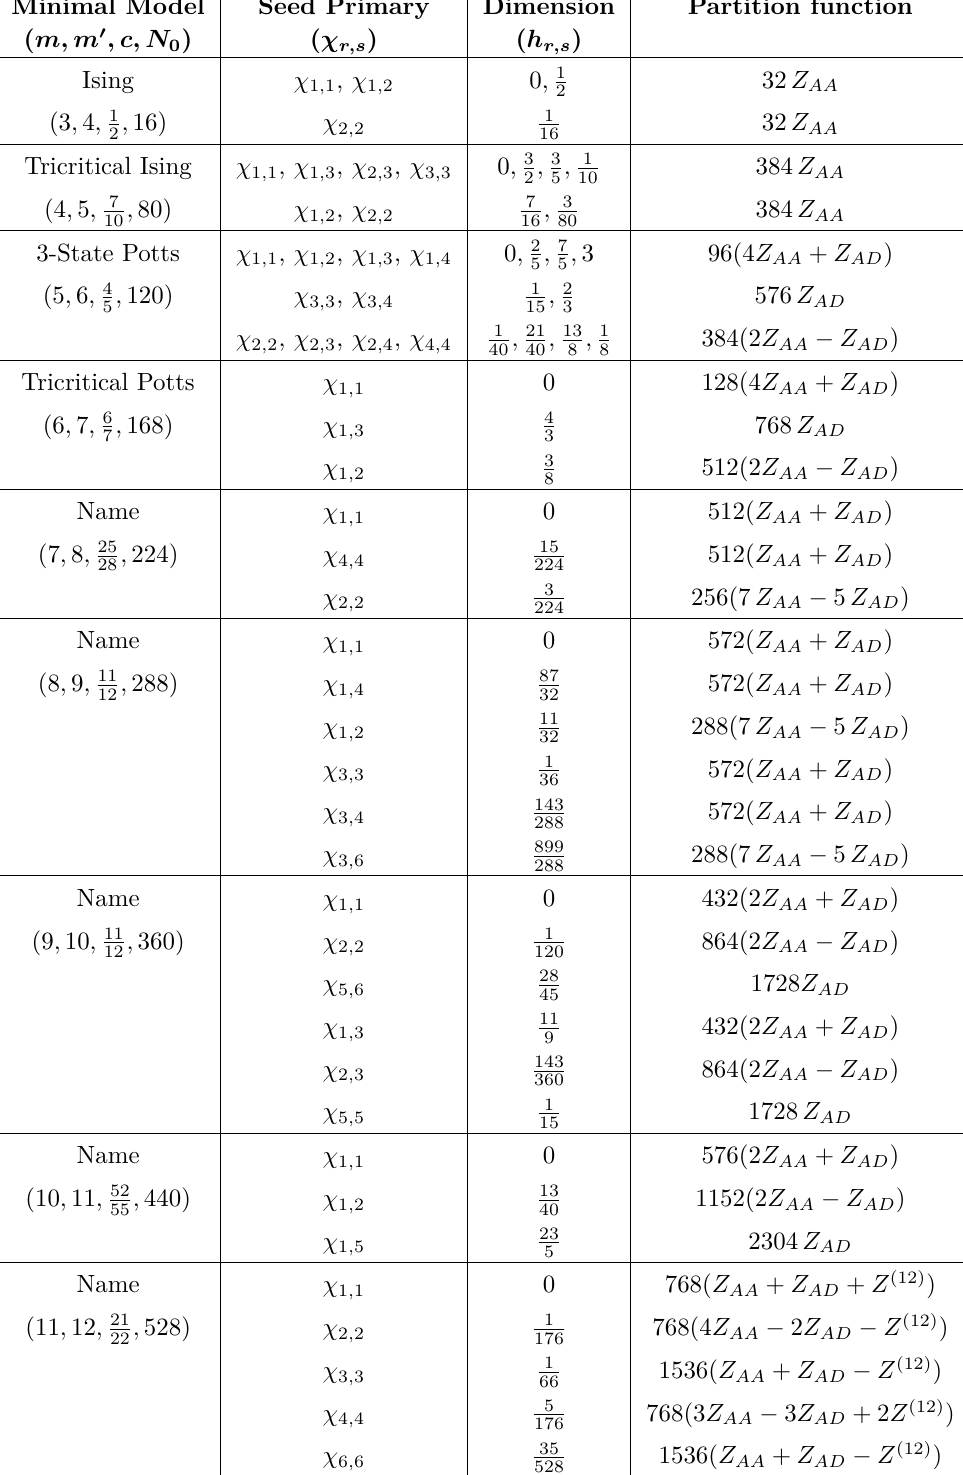
Table 8. Poincaré Sums for unitary Virasoro minimal